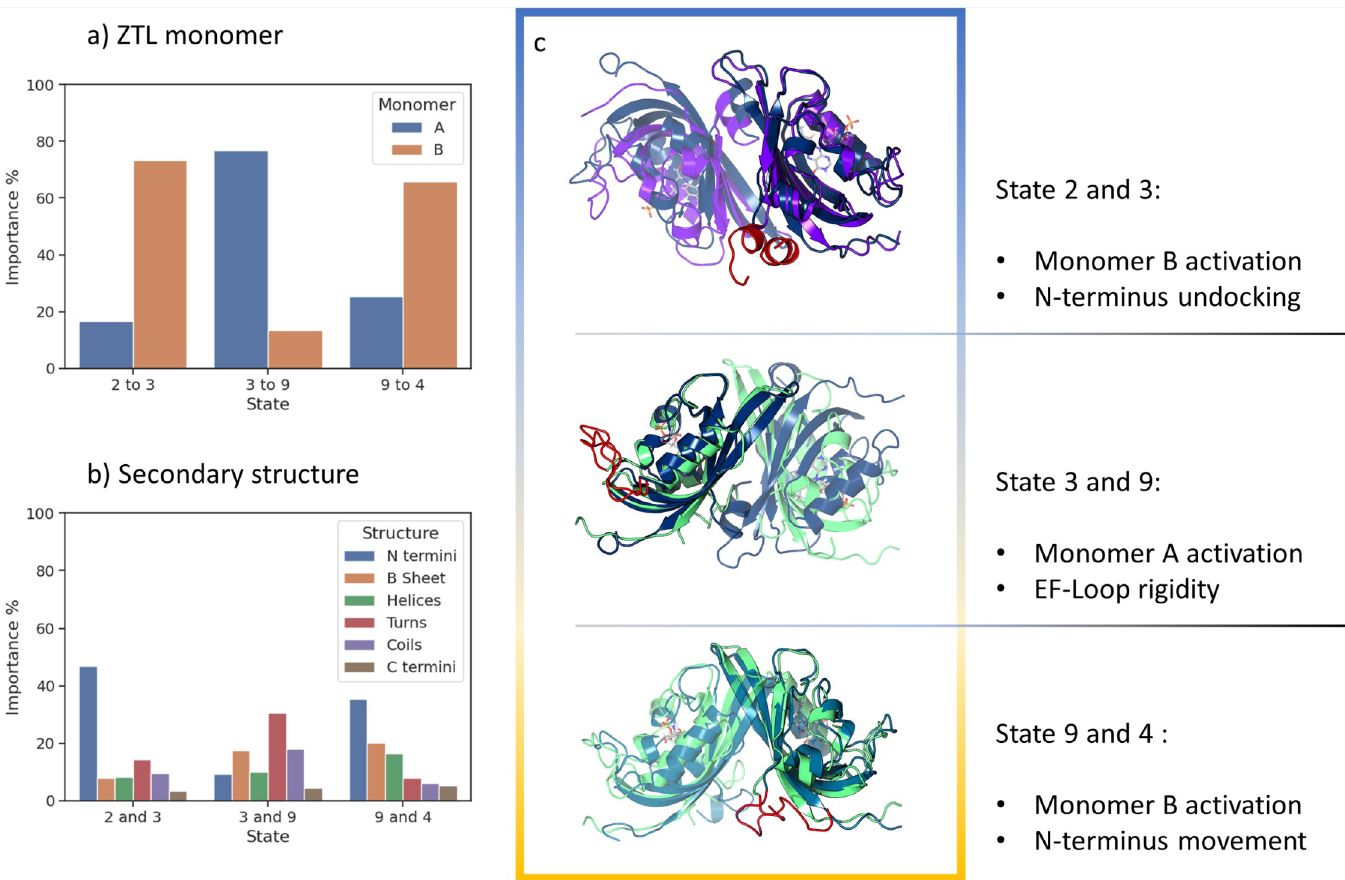
Fig 9. Structural changes among ZTL metastable states. a) Contribution from each ZTL monomer; b) Contribution from secondary structure. c) Illustration of important structural changes, highlighted in red, for each allosteric